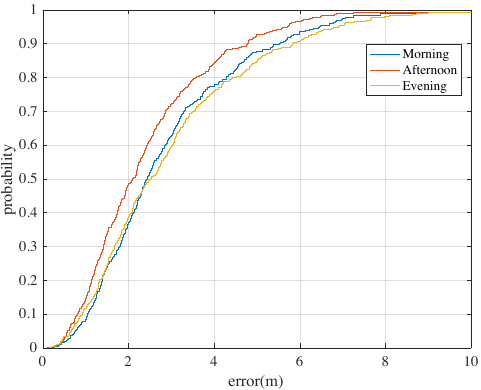
Figure 13. The CDFs of Wi-Fi-based positioning errors adopting the constructed RM at different times of a day using the classical baseline positioning algorithm: the kNN algorithm.